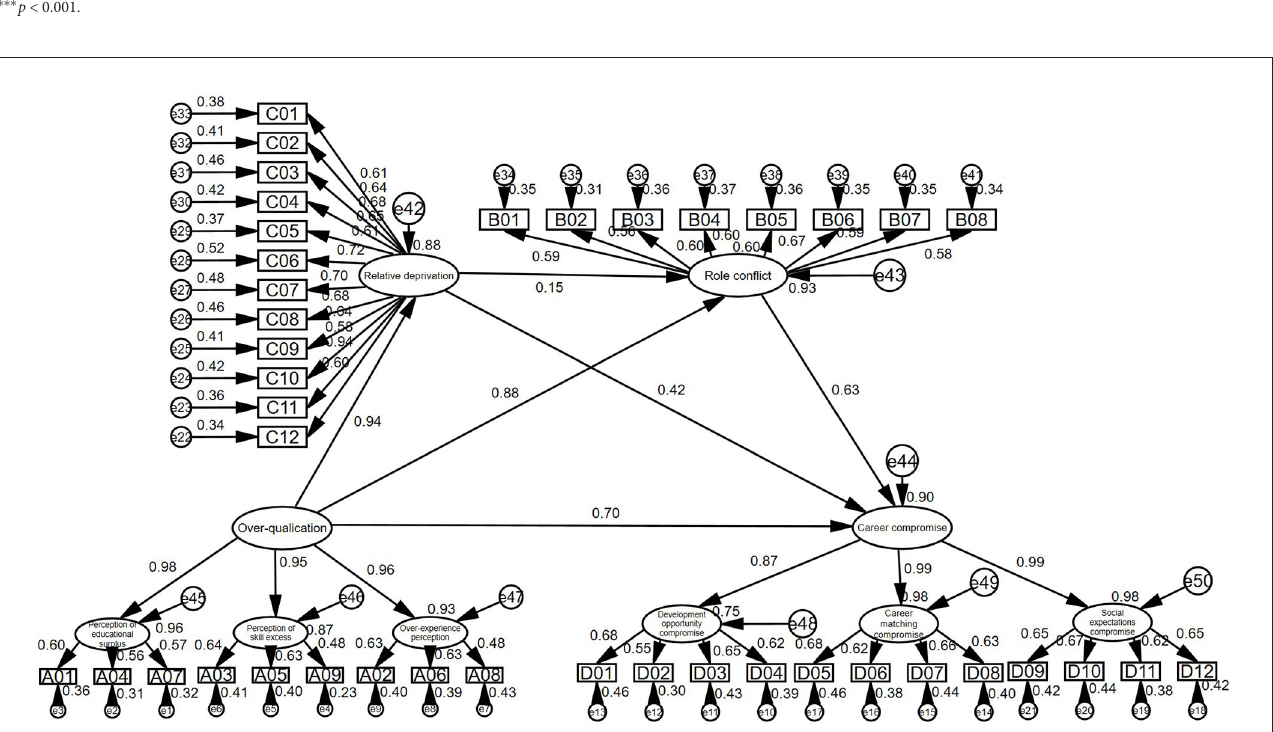
FIGURE2 Statistical diagram of standardized path coefficient of structural equation model.